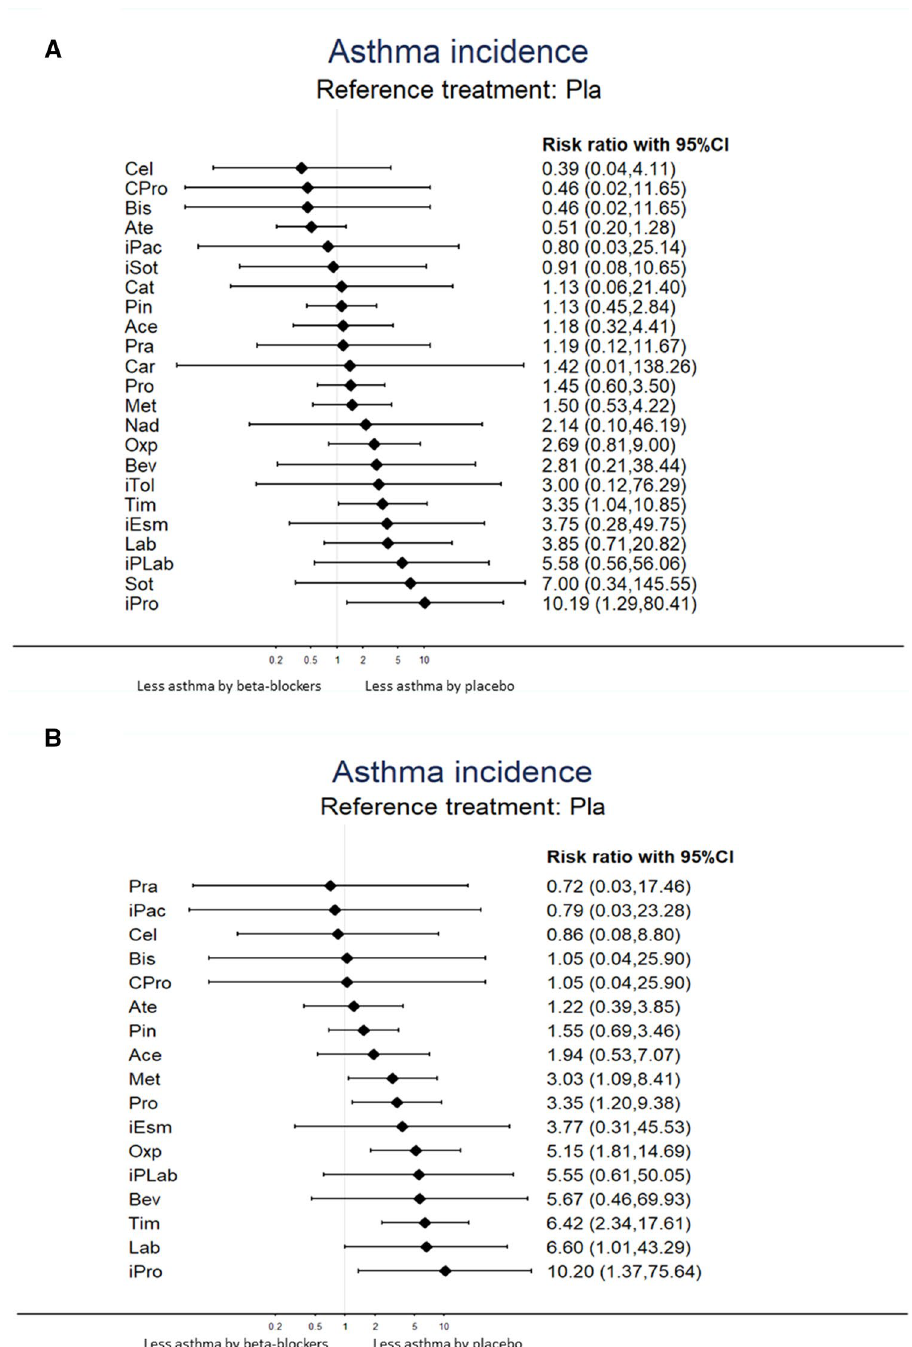
Figure 3. Forest plot of the incidence of asthma attack by ( A ) individual beta-blocking agents among the overall participants and ( B ) individual beta-blocking agents among participants with a baseline history of asthma. An effect size (presented as risk ratio) of < 1 corresponds to a lower incidence of asthma attack by specified beta-blocking agent compared with that by the placebo or control group. Ace oral acebutolol, Ate oral atenolol, Bev oral bevantolol, Bis oral bisoprolol, Car oral carvedilol, Cat oral carteolol, Cel oral celiprolol, CI confidence interval, CPro oral celiprolol and propranolol, iEsm infusion of esmolol, iPac infusion of practolol, iPLab infusion of propranolol and labetalol, iPro infusion of propranolol, iSot infusion of sotalol, iTol infusion of tolamolol, Lab oral dilevalol or oral labetalol, Met oral metoprolol, Nad oral nadolol, Oxp oral oxprenolol, Pin oral pindolol, Pla Placebo/control, Pra oral practolol, Pro oral propranolol, Sot oral sotalol, Tim oral